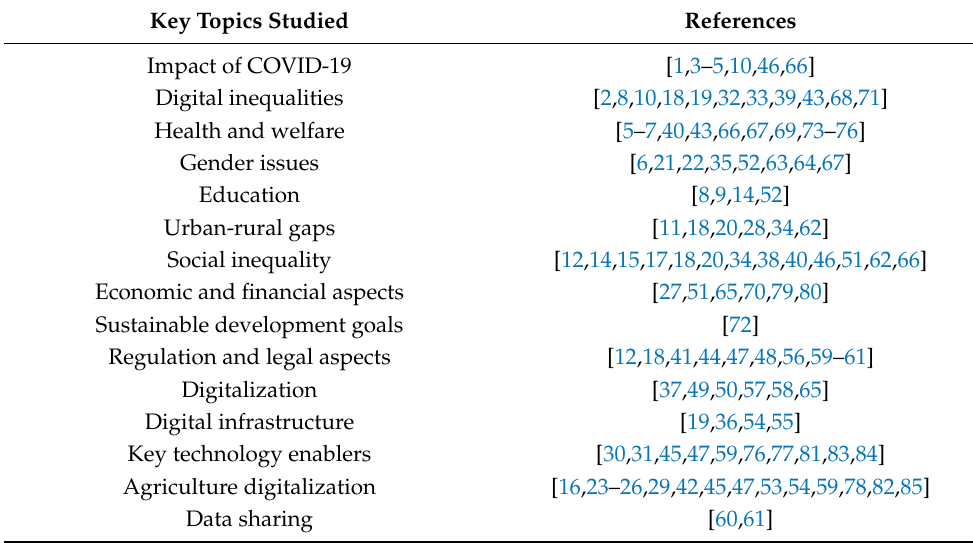
Table 1. Key topics considered in this study. Key Topics